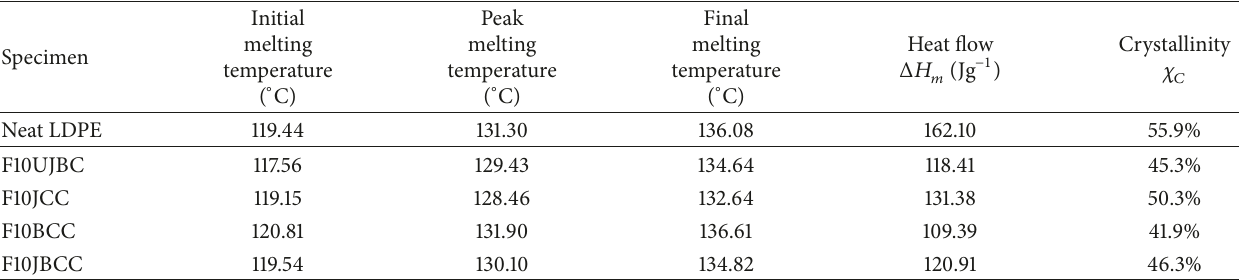
end of decomposition. d Mass loss at temperature corresponding to the onset of decomposition. e Mass loss at temperature corresponding to the maximum rate of mass loss. f Mass loss at temperature corresponding to the end of decomposition. Table 3: Melting characteristics of neat LDPE, UJBC, JCC, BCC, and JBCC at 10wt% cellulose fiber loading.